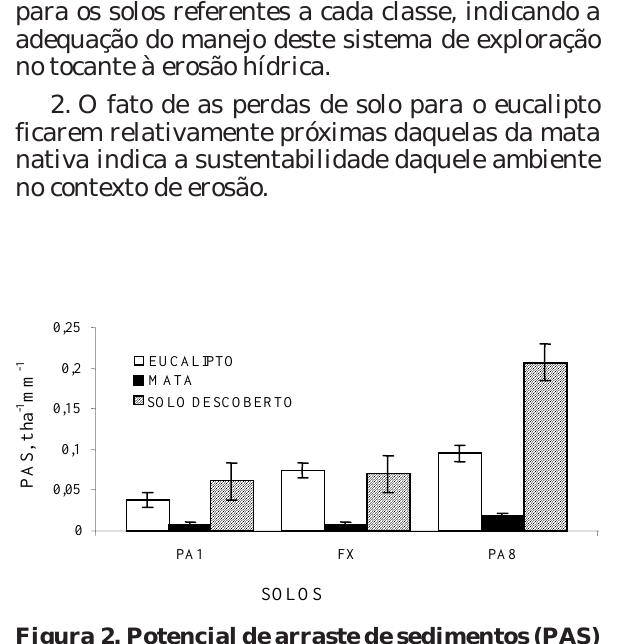
Figura 2. Potencial de arraste de sedimentos (PAS) para os diferentes solos e coberturas estudadas.